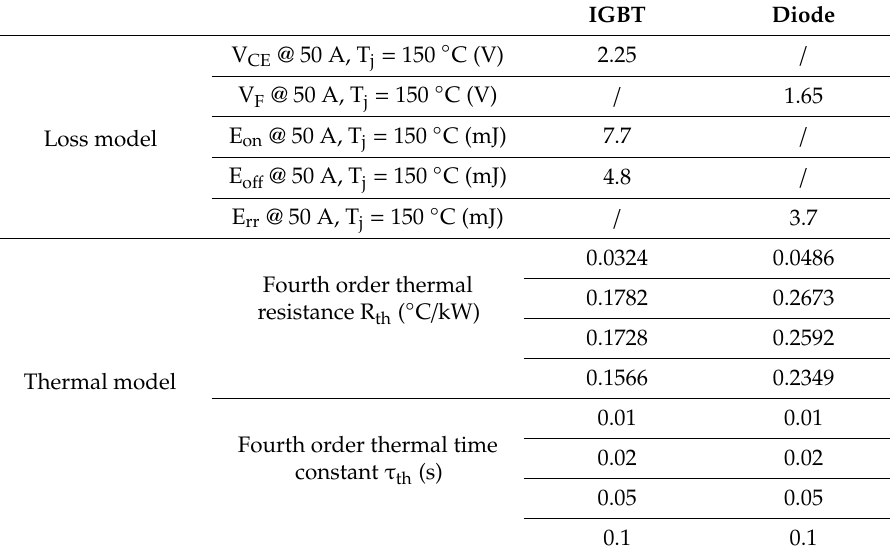
Table 2. Parameters Used in Loss Model and Thermal Model of Power Semiconductors